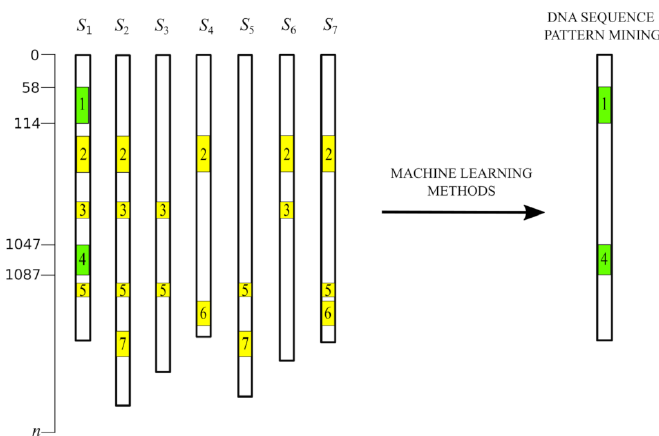
Figure 1. A diagram showing the use of machine-learning methods to find patterns and similarities in nucleotide sequences. By studying different nucleotide sequences with the use of machine- learning methods, unique DNA fragments can be found that are distinctive patterns of a DNA sequence. Two unique sequences (1 and 4) in the S 1 sequence tested are marked green. Abbreviations: S 1 , . . . , S 7 —denote different genome sequences (different nucleotide sequences in genomes); the numbers 1, 2, 3, 4, 5, 6, 7—denote nucleotide sequences that occur in the sequences tested; the numbers: 58, 114, 1047, 1087—denote the sequence position in the genome; the unique DNA fragments are denoted by green color; the nonunique DNA fragments are denoted by yellow